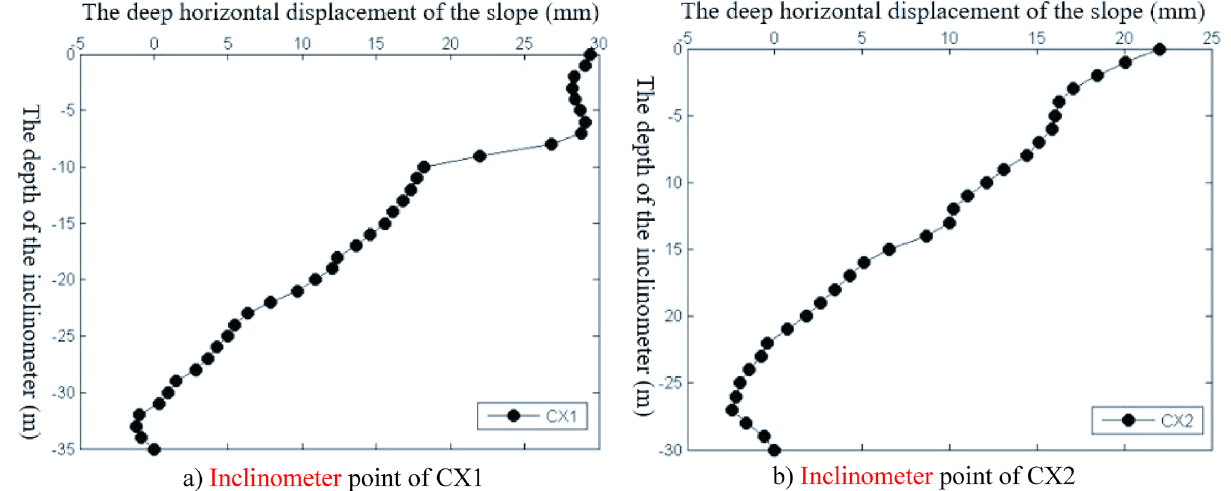
Figure 8. Accumulated deformation curve of the inclinometer point of the Damao slope from July 26 to November 15.